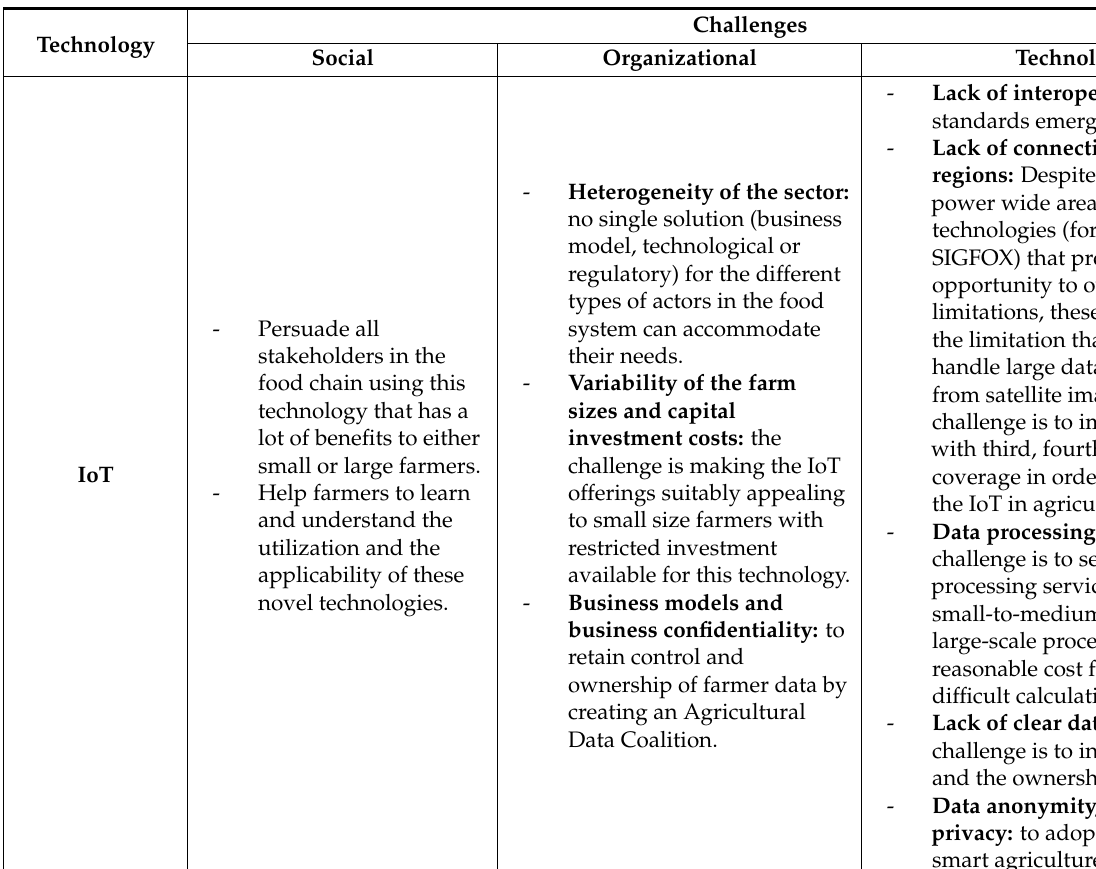
Table 1. New technology challenges and constraints of the agri-food